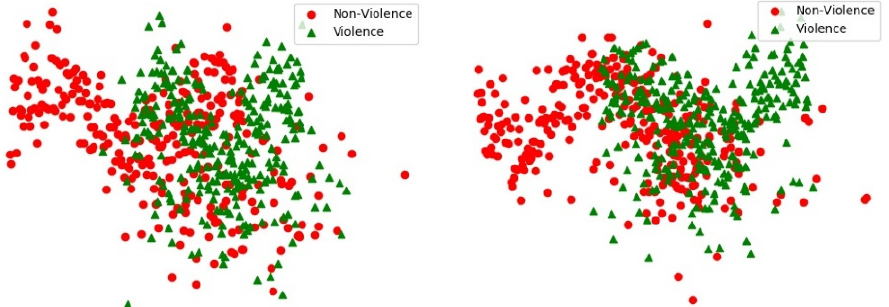
Figure 5. Visualization of feature distribution in ultimate feature space.